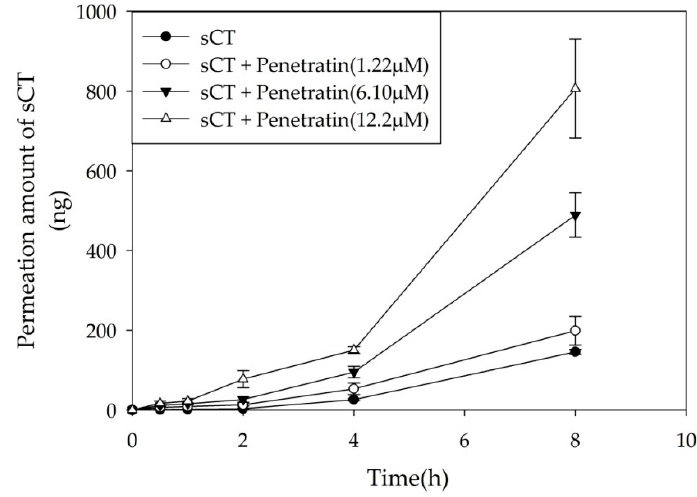
Figure 6. sCT permeation across TR146 cell layer. Cellular permeation of sCT increased as Penetratin concentration dependently. All data were represented by mean ± S.D ( n = 3).